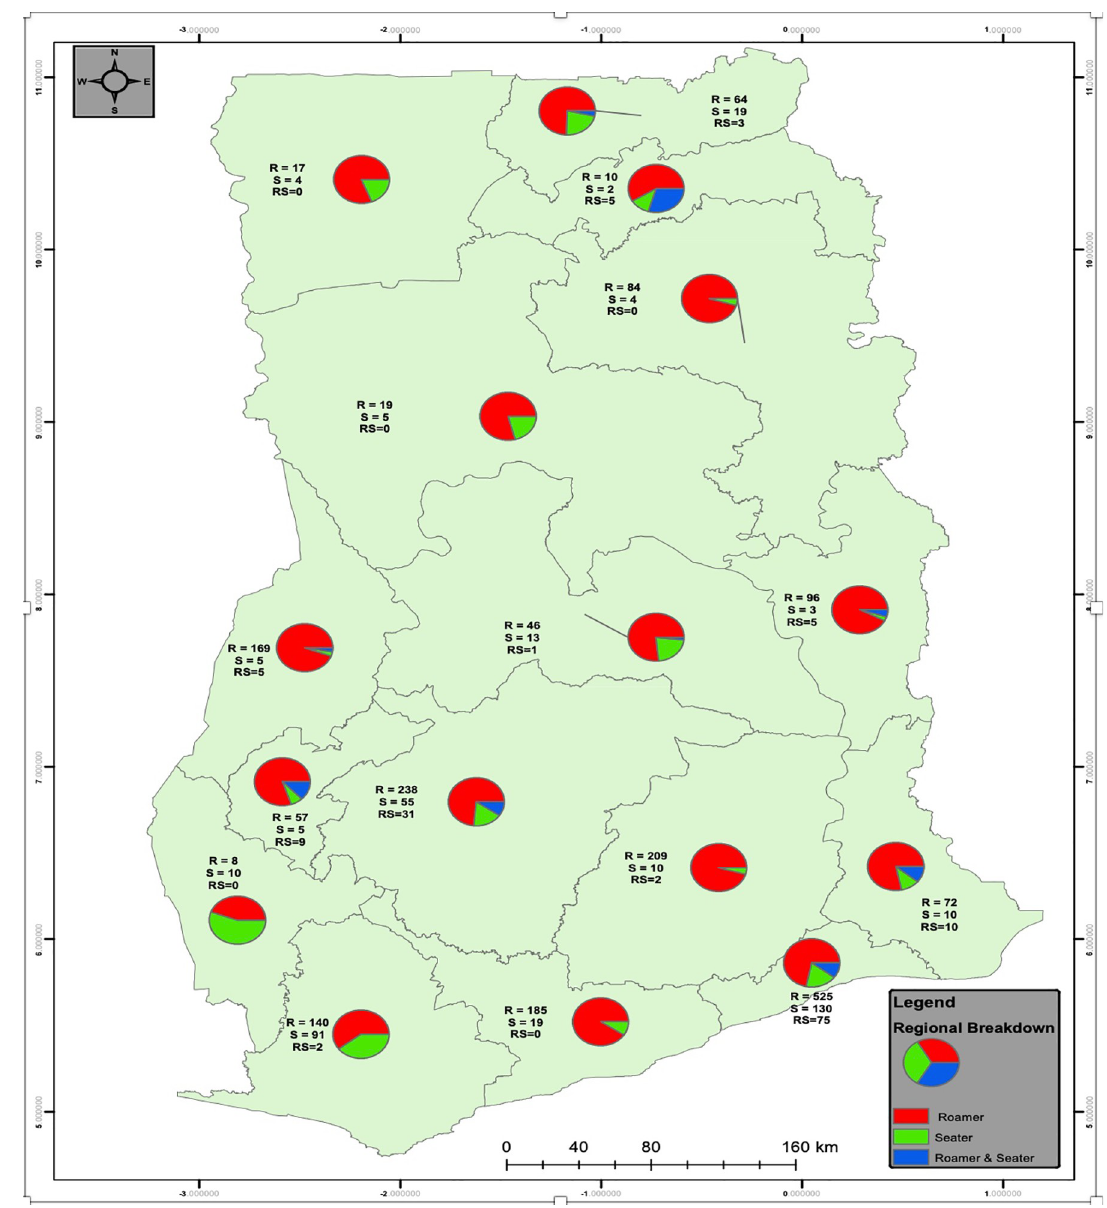
Fig 3. Frequency distribution of venue types among the 16 regions of Ghana,